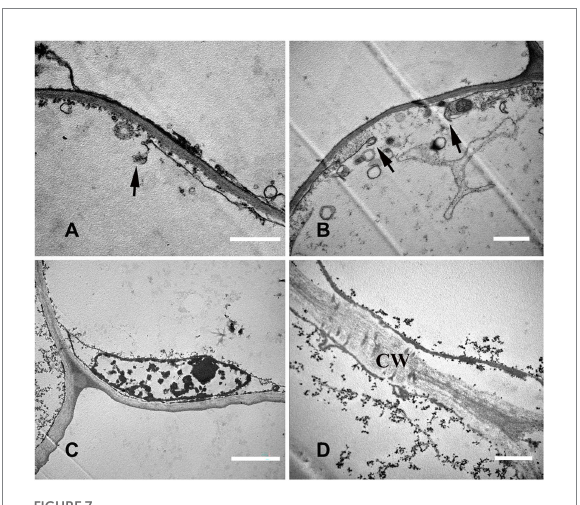
FIGURE 7 Cell ultrastructure of aerenchyma formation in N. nucifera roots (IV). (A—D) The cells in the aerenchyma Mature stage. (A,B) Plasma membrane degradation; (C) Nuclear degradation; and (D) Cell wall degradation. N, nucleus; CW, cell wall. Bars: A,B = 1 μ m, C = 2 μ m, and D = 0.5 μ m.